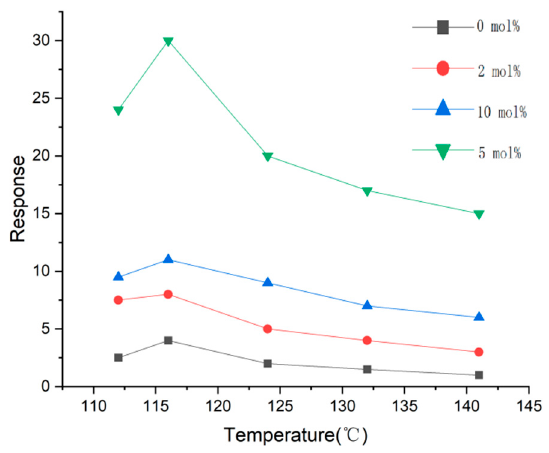
Figure 14. Sensitivity of TiO 2 /BP (varied concentration) to 100 ppm oxygen gas.